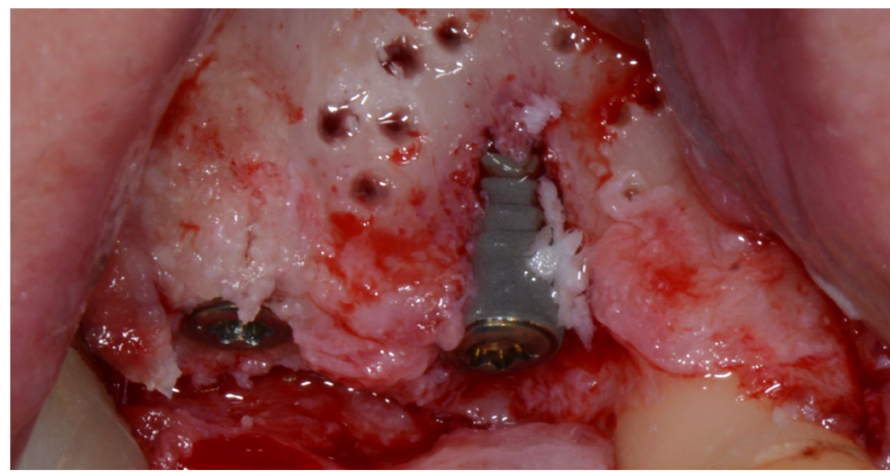
Figure 14. Two implants in place of the one on 11 with several threads exposed. The site of 12 presented a very thin but visible buccal plate, while 11 had most of the buccal coronal aspect of the implant exposed. Some small holes were drilled into the buccal plate to produce some bleeding and with cells from the marrow spaces, while the area was augmented with a mix of autogenous bone scraped from the ramus and a collagenated xenograft. A bone lamina was cut and shaped in order to cover the graft and produce some horizontal and vertical augmentation of the area (Figure 15). We can see that some bone loss to the distal of 21 was also evident. Two pins were placed to the buccal apical aspect of the lamina to keep it firmly in place.